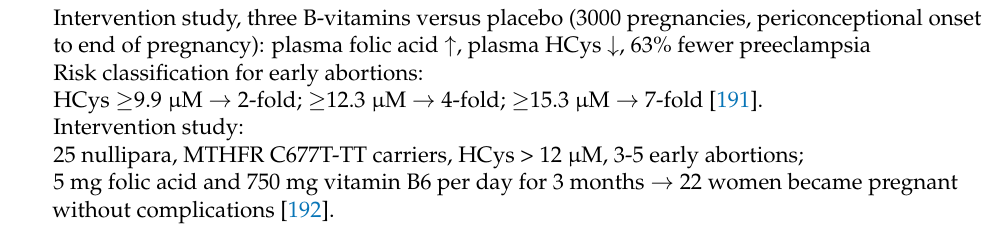
Preeclampsia: decoupling of the endothelial NO synthase (see Figure 4B) → significant reduction in endothelium-dependent